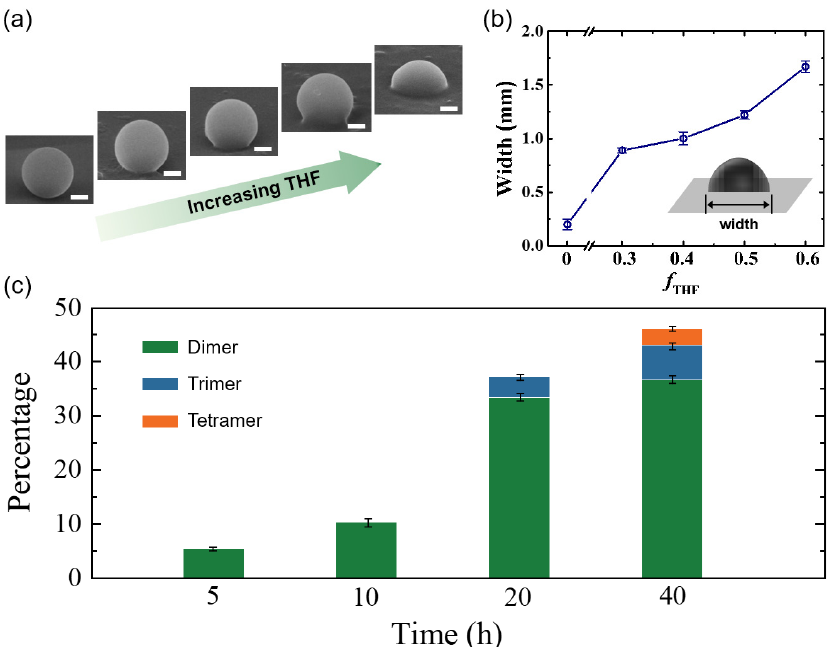
Figure 2. ( a ) SEM images of one PS particle on a silicon wafer after incubation in THF/water mixtures of different THF volume fractions: f THF = 0.1, 0.3, 0.4, 0.5, and 0.6 (left to right). Scale bars: 500 nm. ( b ) Width of the wetting region of the PS particle with the wafer. The width increases with THF fractions. ( c ) The yield of PS–AgCl active colloids for different incubation times at f THF = 0.4. The error bars in ( b , c ) are standard deviations and some error bars are smaller than the symbols in ( b ).